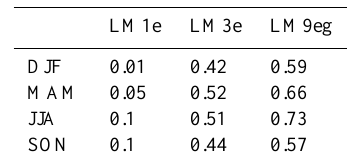
Table 3. Adjusted R 2 for three linear models (see Table 1) and for each